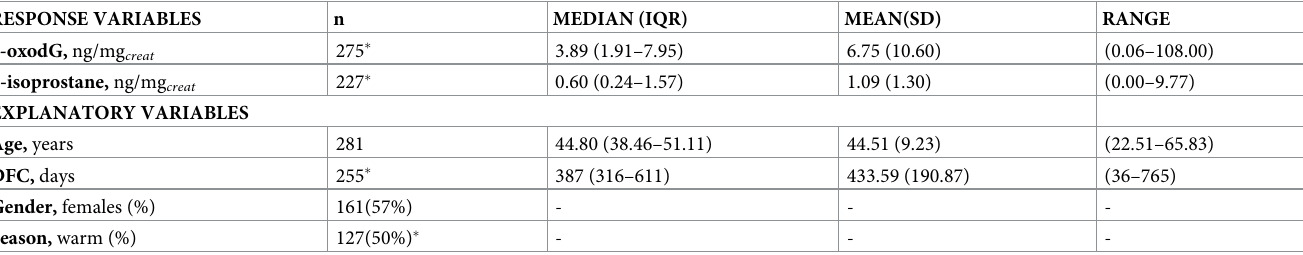
Table 1. Characteristics of the